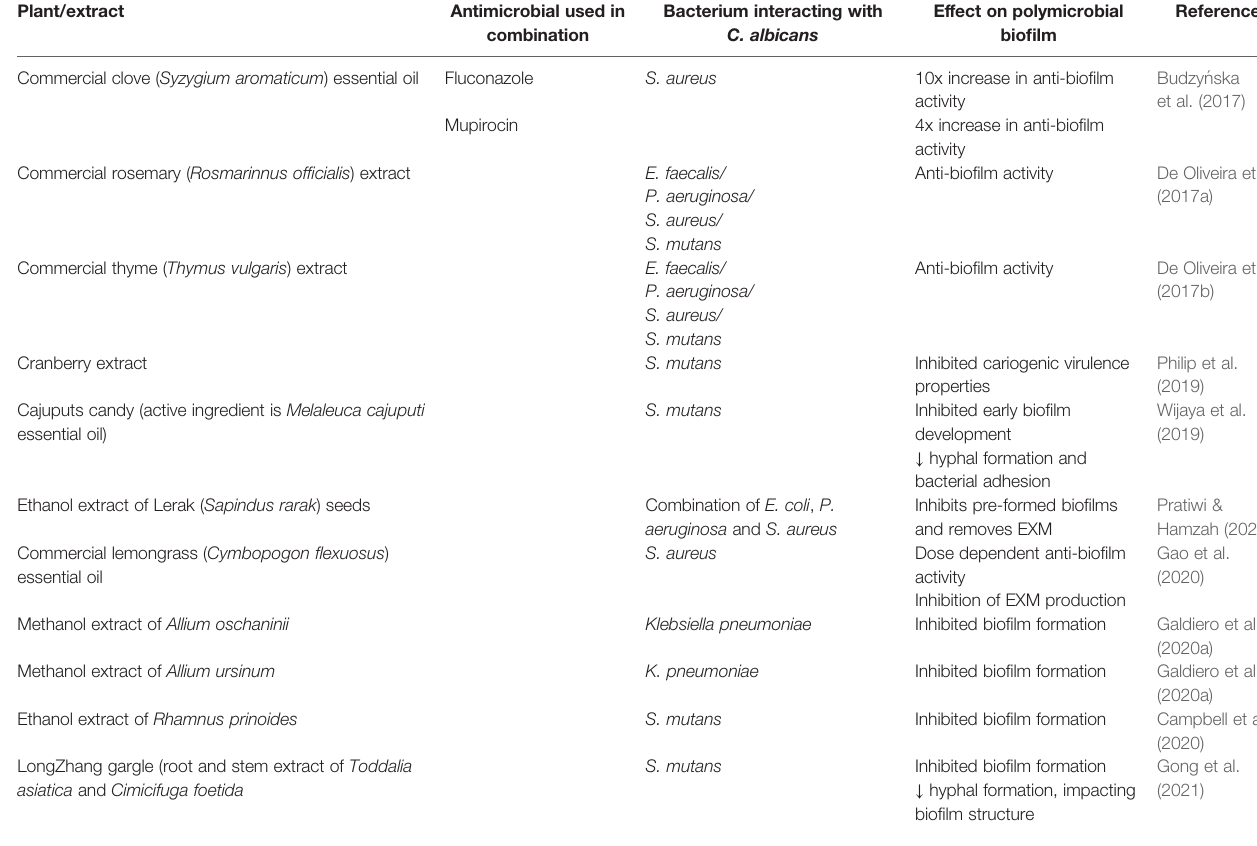
TABLE 3 | Plants and extracts with activity against Candida albicans containing polymicrobial bio fi lms. Plant/extract